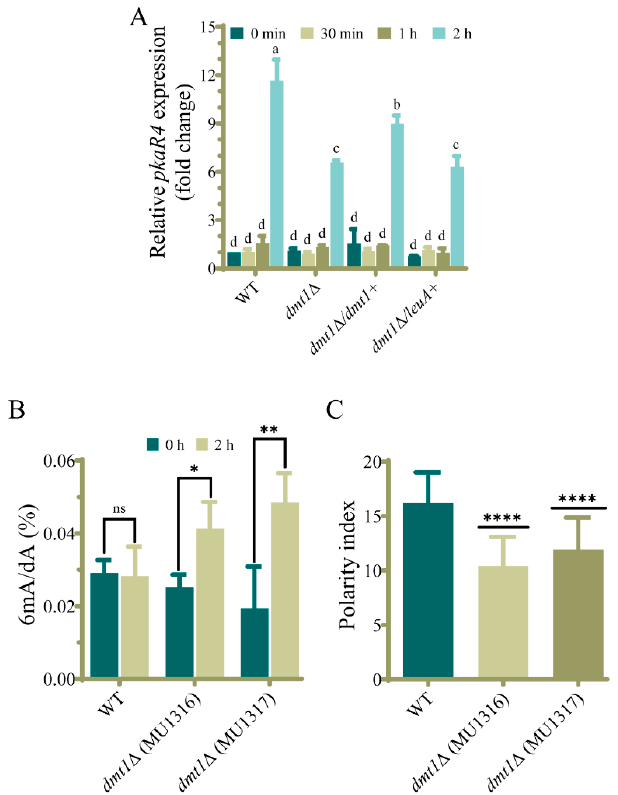
Figure 4. The gene dmt1 is required for appropriate expression of the pkaR4 gene during yeast to hyphae transition. ( A ) mRNA levels of pkaR4 were determined by RT-PCR from total RNA isolated from MU636 (WT), dmt1 ∆ (MU1317), dmt1 ∆ complemented with dmt1 wild-type allele (MU1331), and dmt1 ∆ complemented with empty cassette (MU1334) at different times (0 min, 30 min, 1 h, and 2 h) after induction of transition from yeast to mycelium. The amplification levels of ef-1 were used to normalize the relative expression of pkaR4 using the 2 − ∆∆ CT method. ( B ) Levels of 6mA, determined by HPLC-MS analysis, in genomic DNA isolated from yeast cells before (0 h) and 2 h after transferring them to aerobic conditions of the wild-type strain MU636 (WT) and dmt1 mutants (MU1316 and MU1317). ( C ) Polarity index of the wild-type strain MU636 (WT) and dmt1 mutants MU1316 and MU1317 measured 5.5 h after phagocytosis by mouse macrophages line J774A.1. The polarity index was calculated from 50 phagocytosed spores. The charts display means ± SD. Different letters above the bars indicate statistical significance, while the identical letters denote no significant differences ( p < 0.05, Tukey test). Asterisks denote a significant difference calculated using one-way ANOVA (**** p < 0.0001) and unpaired t -test (* p < 0.05, ** p < 0.001; ns, not